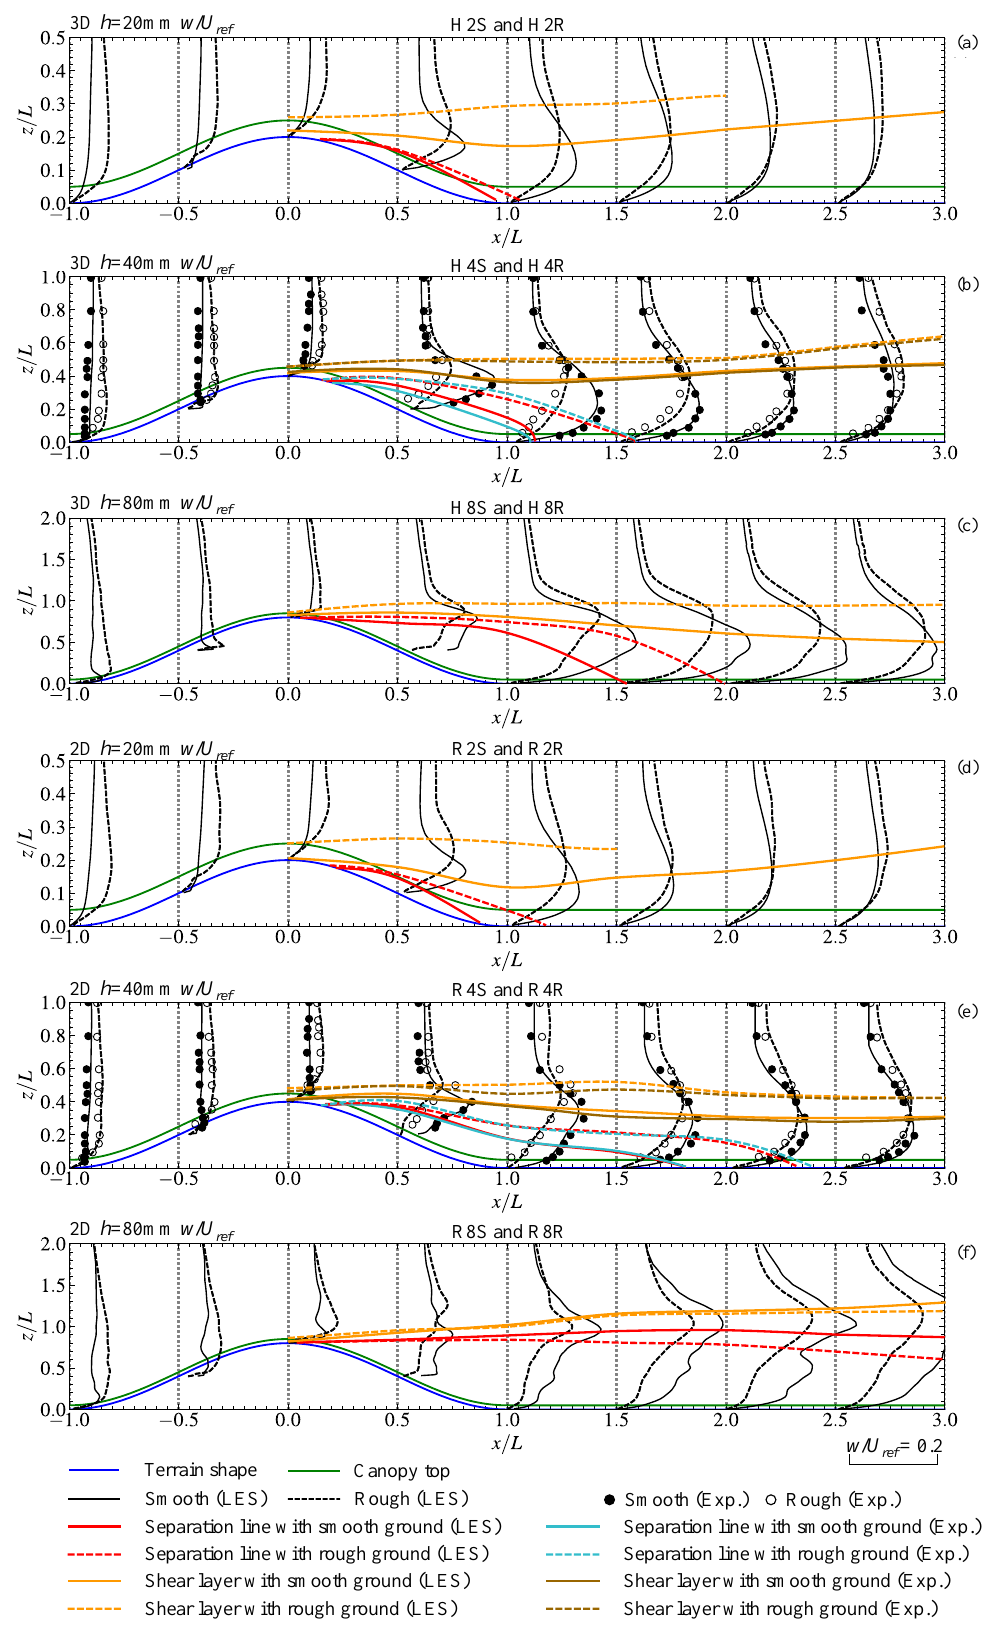
Figure 8. Vertical profiles of w , ( a ) 3D hills with h = 20 mm, ( b ) 3D hills with h = 40 mm, ( c ) 3D hills with h = 80 mm, ( d ) 2D hills with h = 20 mm, ( e ) 2D hills with h = 40 mm, and ( f ) 2D hills with h = 80 mm.